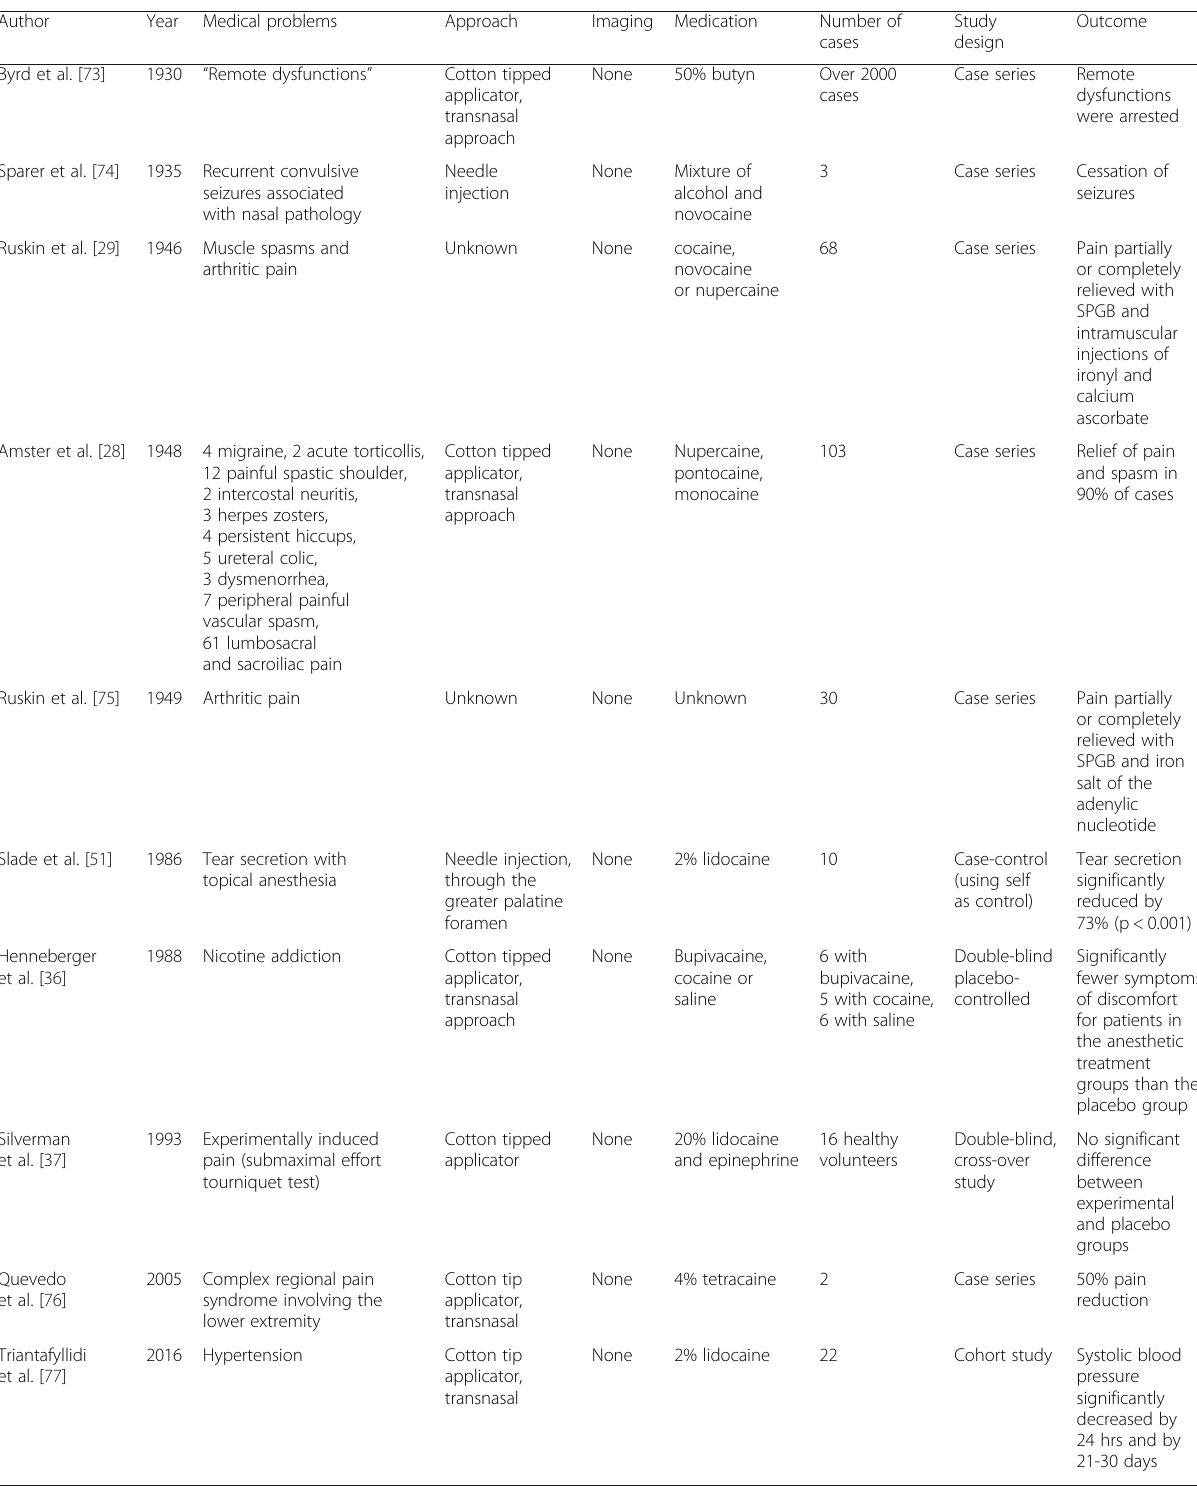
Table 12 Studies of SPG blocks for other syndromes Other